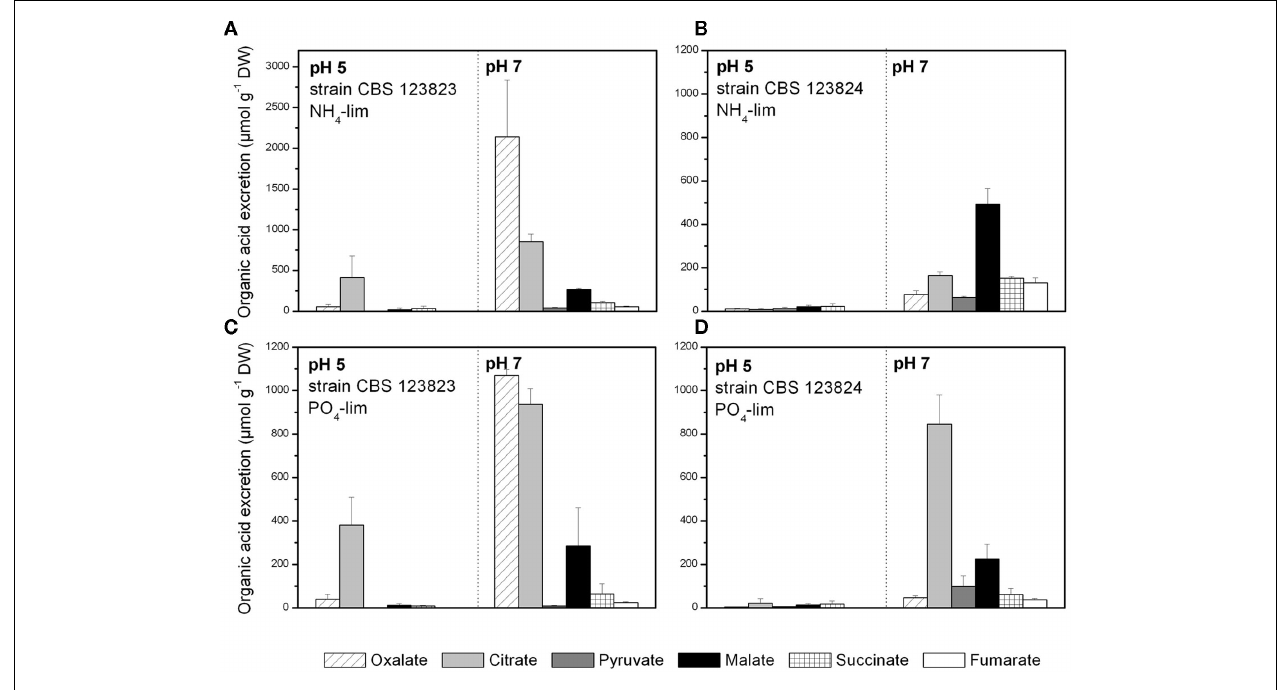
of cultivation, (C) pH 5 at 35.0 ± 0.65h and pH 7 at 34.33 ± 0.88h of cultivation, and (D) pH 5 at 36.7 ± 0.33h and pH 7 at 34.5 ± 0.49h of cultivation. Data are means of three independent bioreactor batch cultivations (single curves see Figures 4 – 6 ), except phosphate-limited cultures of strain CBS123824 at pH 5 (D) , which were performed